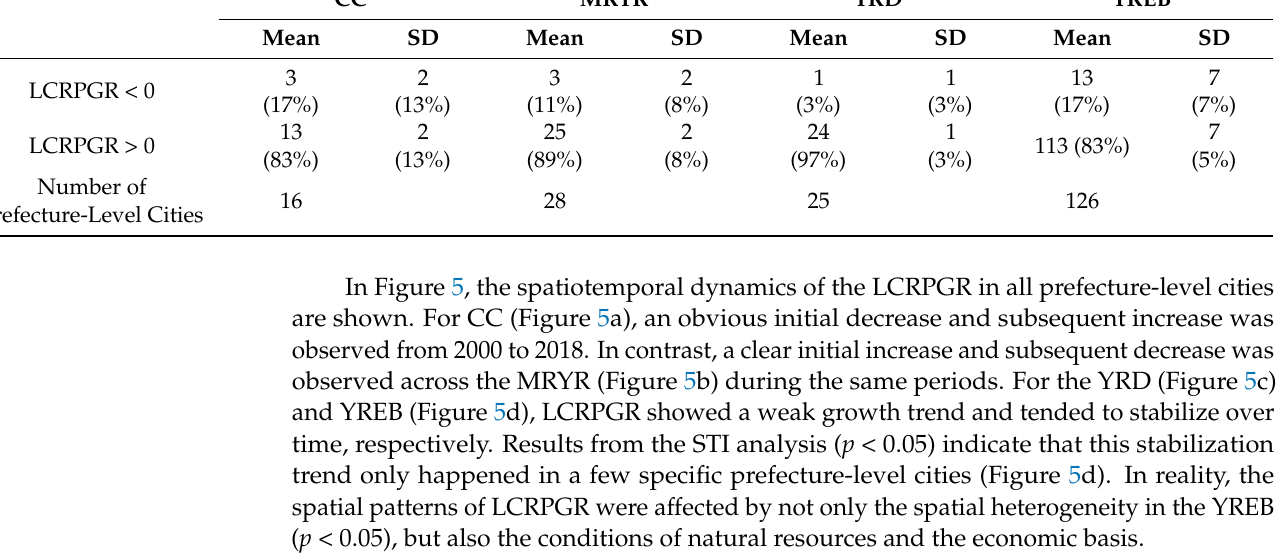
Table 2. Statistics on the number prefecture-level cities of LCRPGR < 0 and LCRPGR > 0 for 2000–2010,